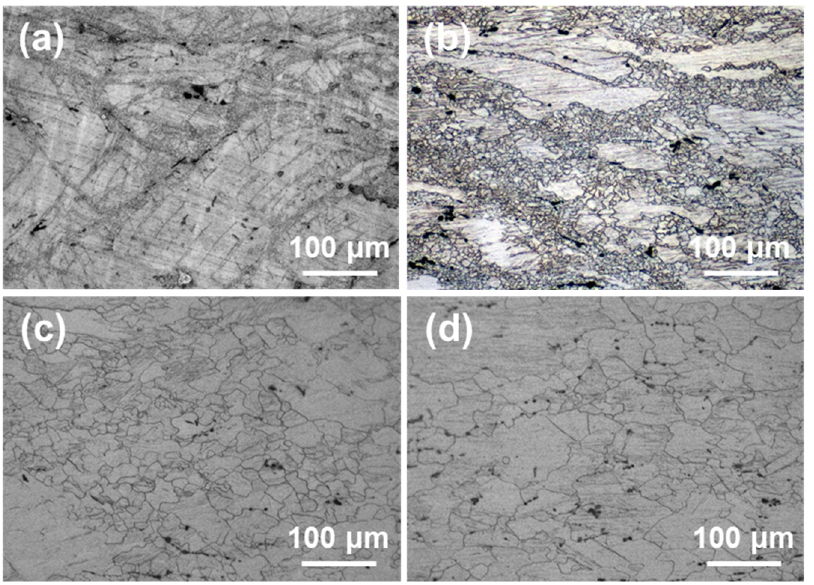
Figure 7. OM of Mg-3Sn-2Al-1Zn-0.6Nd alloy under different hot deformation conditions: ( a ) 200 °C/1 s − 1 , ( b ) 250 °C/0.01 s − 1 , ( c ) 350 °C/0. 1 s − 1 , and ( d ) 350 °C/0.001 s − 1.